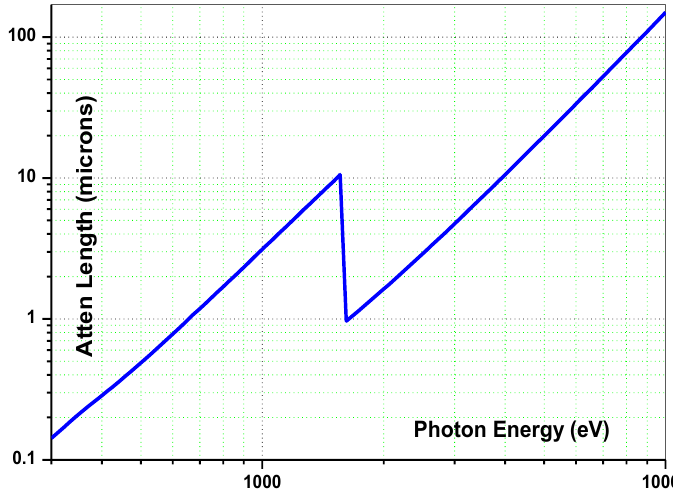
Figure 8. Attenuation length of photons in aluminum against the photon energy.